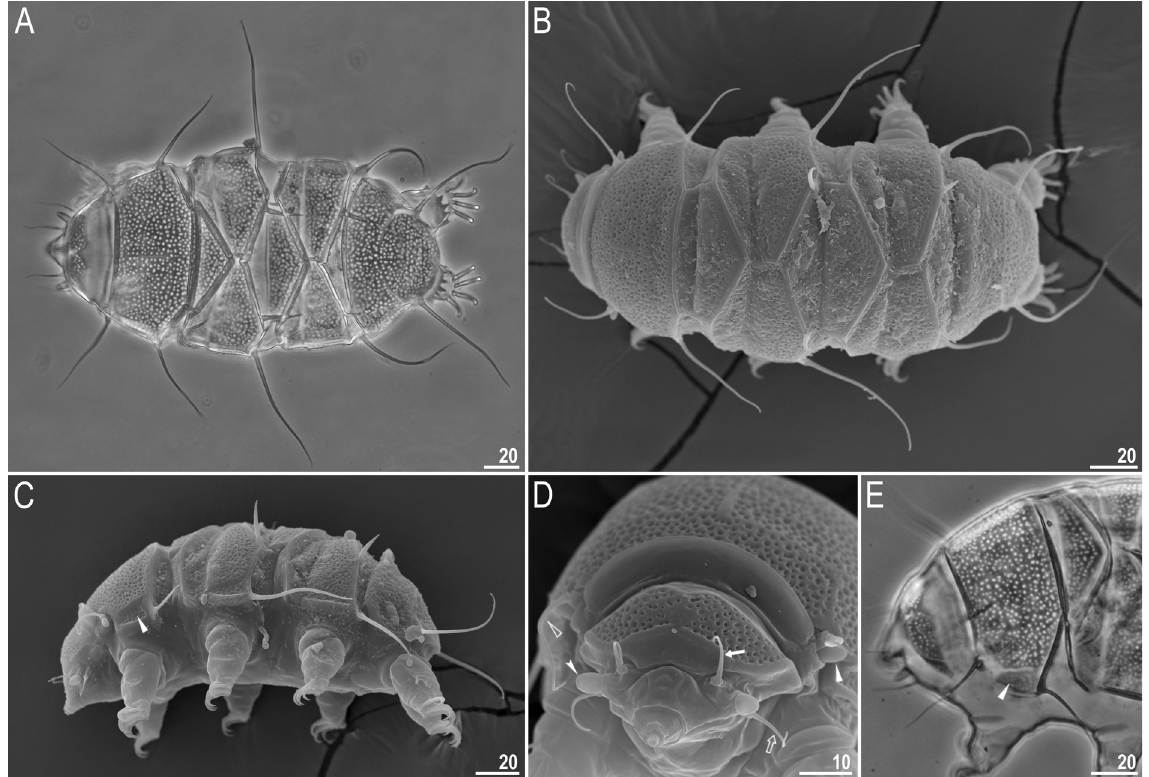
Fig. 1. Echiniscus quadrispinosus Richters, 1902, ♀, habitus. A*–B . Dorsal view of the entire animal with typical chaetotaxy A-B-C-C d -D-D d -E (PCM and SEM, respectively). C . Lateral view; arrowhead indicates additional plate divided from the lateral margin of the scapular plate (SEM). D . Head and scapular plates and head appendages visible in SEM; empty arrow indicates external cirri, filled arrow indicates internal cirri, indented arrowhead indicates cephalic papillae, empty arrowhead indicates appendage A and filled arrowhead indicates clava. E . Lateral view of head and scapular plates; arrowhead indicates additional plate divided from the lateral margin of scapular plate (PCM). * = manually assembled deep- focus image. Scale bars in micrometres